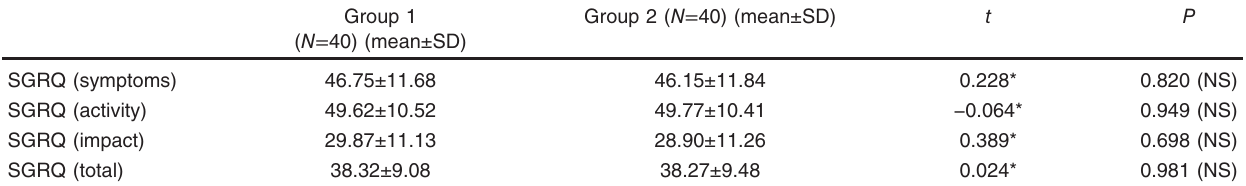
Table 4 Comparison between group 1 and group 2 regarding pretreatment health status evaluation measured by Saint George respiratory